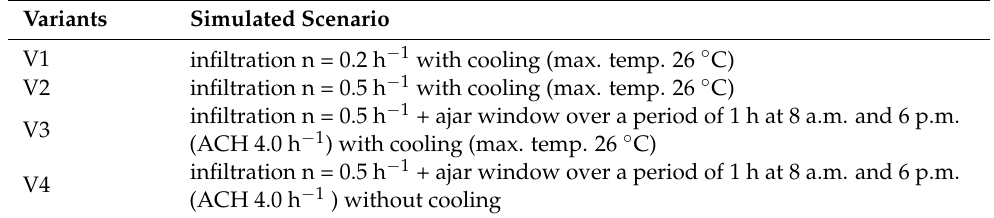
Table 2. Variants of estimated air